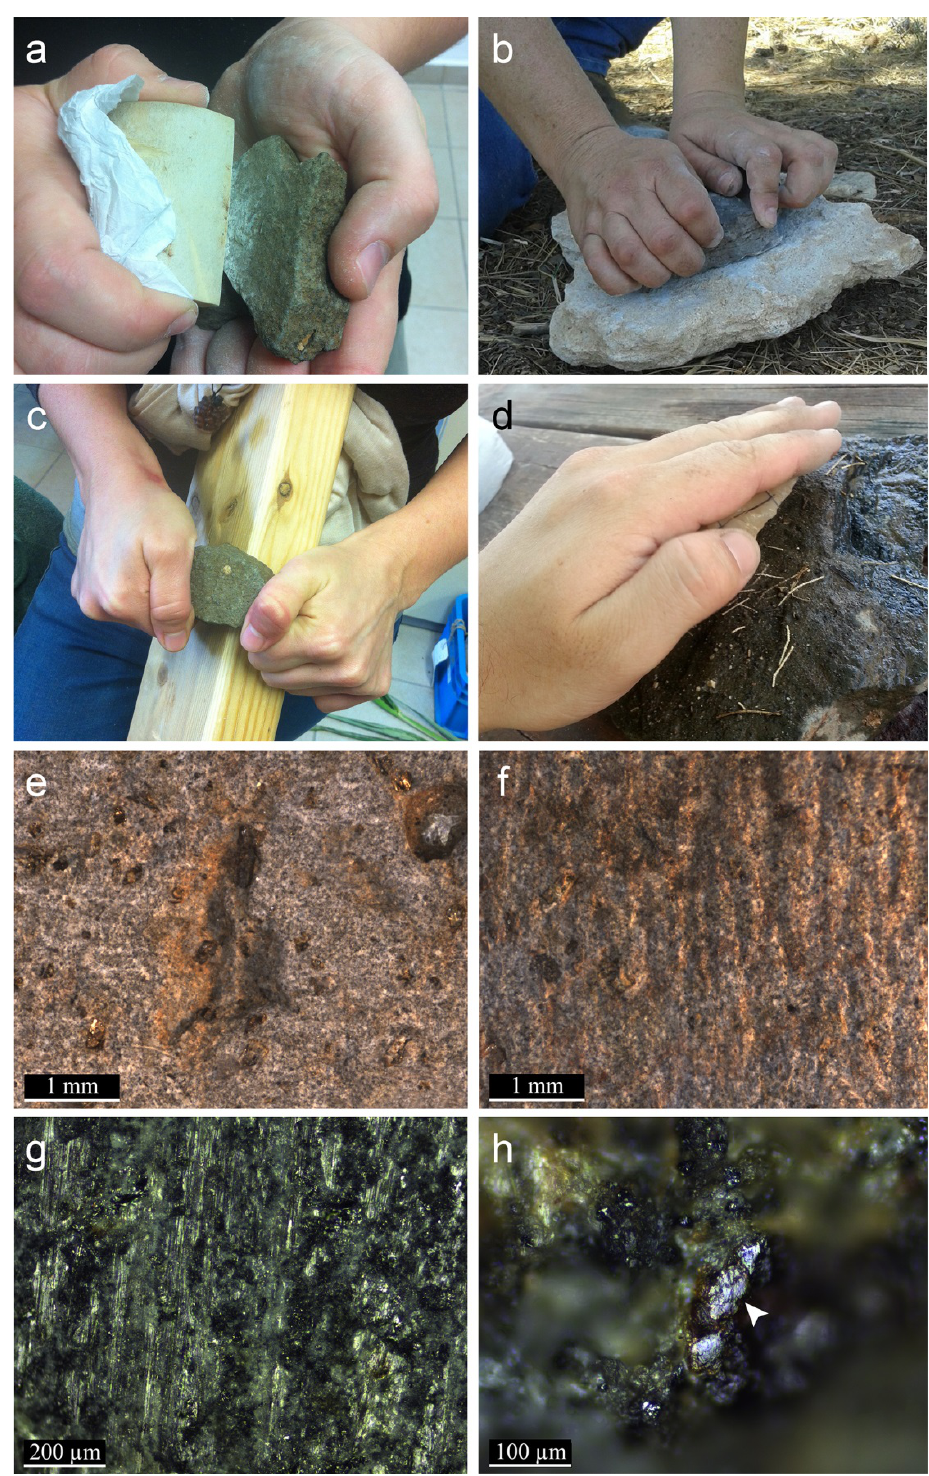
Figure 2: Photos of some of the experiments conducted and wear patterns observed on the experimental pieces: a) abrasion against a piece of bone, b) coastal aeolianite or ' Kurkar ', c) wood log, d) abrasion with flint, e) flat surface exhibiting large pits with abrupt edges and unmodified bottom produced by abrasion against basalt for 30 minutes (original magnification x20), f) rough but levelled surface with multiple shallow grooves indicating the direction of abrasion produced by abrasion against travertine for 30 minutes (original magnification x20), g) flat surface with heavily striated micro-polish indicating the direction of abrasion developed on protruding surfaces of the basalt produced by abrasion against ‘ kurkar ’ for 60 minutes (original magnification x200), h) bright domed micro-polish developed on protruding points of the basalt produced by the abrasion against a wood log for 30 minutes (original magnification